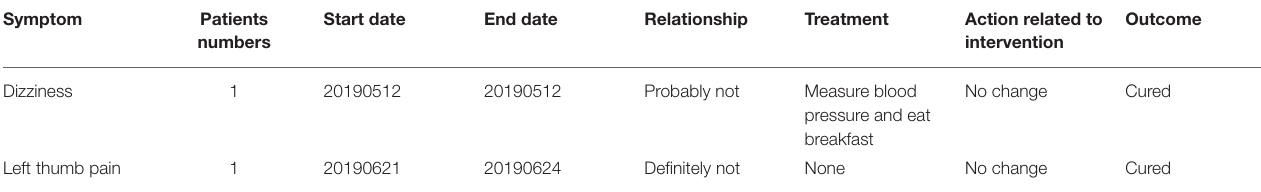
TABLE 5 | Adverse